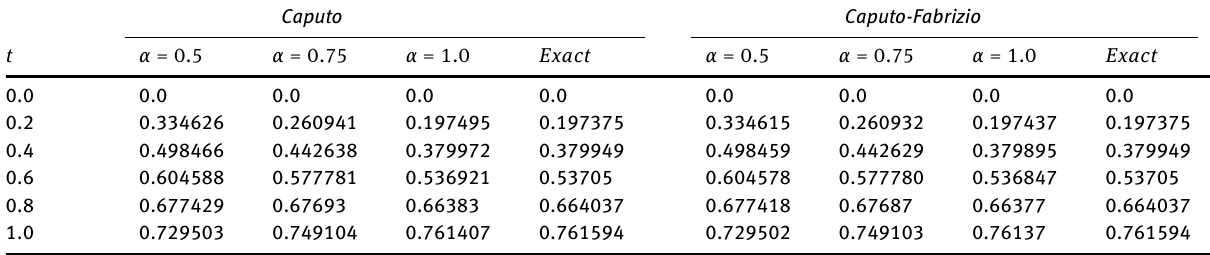
Table 1: The exact and approximate result of test example 5.1 featuring various values of α , with Caputo and Caputo-Fabrizio derivative. Caputo